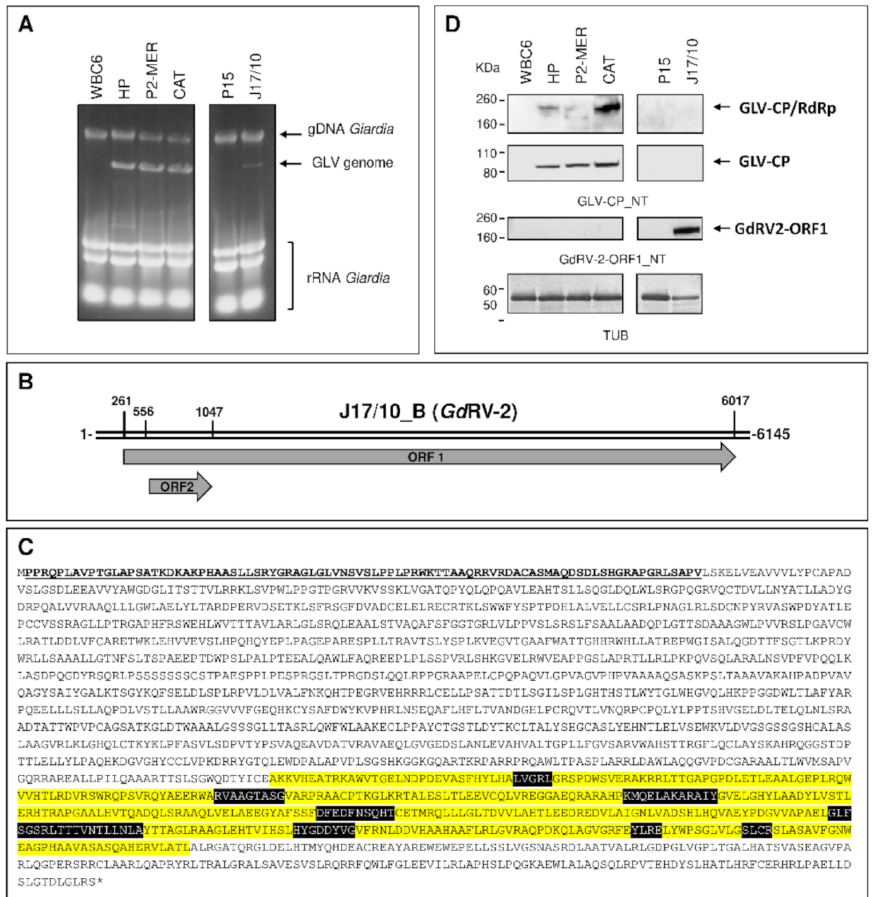
Figure 1. Assessment of virus infection in G. duodenalis isolates. ( A ) Ethidium bromide stained agarose gel electrophoresis (0.8%) of the total nucleic acid isolated from G. duodenalis isolates infected or not with GLV. The band corresponding to Giardiavirus dsRNA is indicated (GLV genome), together with the G. duodenalis genomic DNA (gDNA) and ribosomal RNA (rRNA). ( B ) Genomic organization of the J17/10_ B virus-like (GdRV-2) sequence (6145 bp) encoding for ORF1 (frame +3) and a small ORF2 (frame +1) (see Table 2 for details). ( C ) Deduced amino acid sequence of ORF1 encoded by the J17/10_ B virus-like (GdRV-2). Sequence recognized by the mouse GdRV-2-ORF1_N-terminal pAb are in bold and underlined. BlastP detected domains are indicated by color codes. Putative viral RNA- directed RNA-polymerase domain (RdRp, pfam02123) is yellow-boxed. The eight RdRp conserved subdomain (I to VII) are black-boxed [46]. ( D ) Expression of the GLV capsid protein (GLV-CP) and GdRV-2 ORF1 in G. duodenalis. Western blot analysis of protein extracts (50 µ g) from trophozoites of G. duodenalis isolates harboring the viruses (HP, CAT, P2-MER and J17/10) or from control naïve isolates (WBC6 and P15). Immunoblotting was performed with mouse anti-GLV-capsid protein_N- terminal pAb (GLV-CP_NT) and mouse anti-GdRV-2-ORF1 N-terminal (GdRV-2-ORF1_NT) pAb. The anti- α -tubulin ( α - α -TUB) was used as loading control. Molecular size markers (kDa) are reported on the left. Arrows indicate the bands corresponding to the GLV-CP, GLV-CP/RdRp and GdRV-2 ORF1. The analysis is representative of three independent